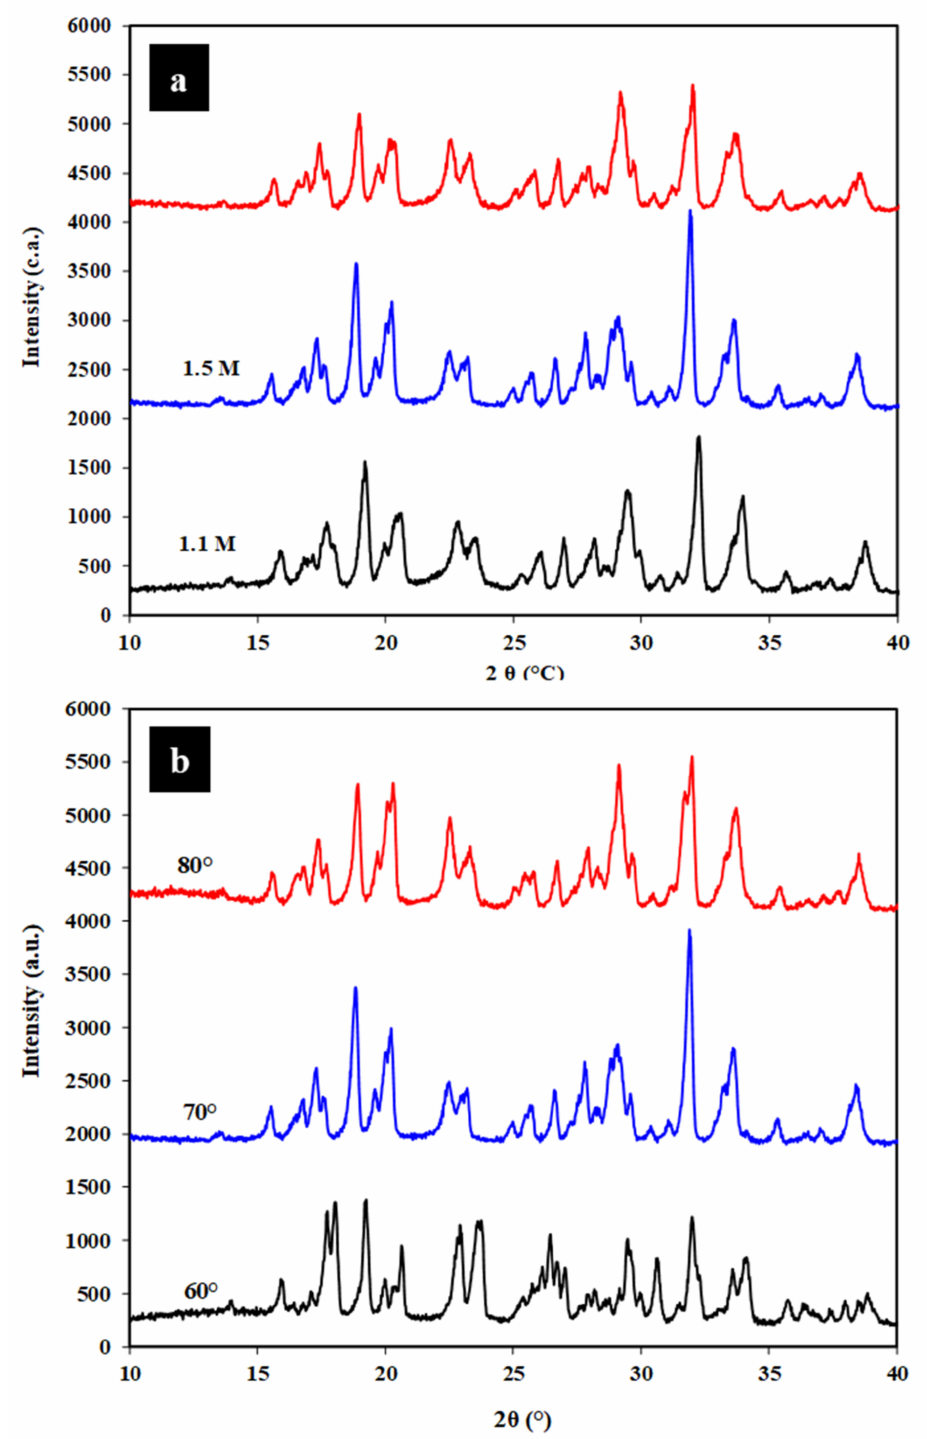
Figure 9. XRD patterns of CNCs obtained under different ( a ) APS concentrations at 70 ◦ C for 16 h and ( b ) oxidation temperatures with a 1.5 M APS concentration for 16